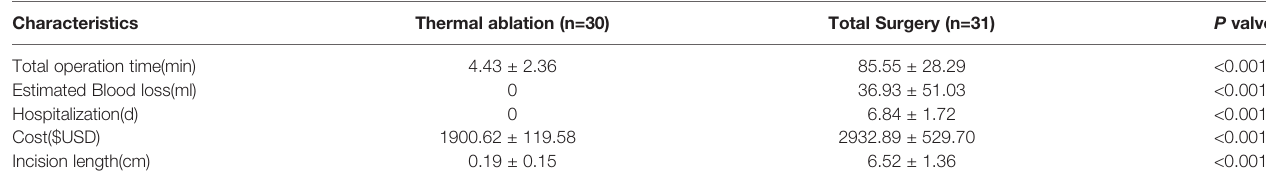
TABLE 4 | Treatment variables of the thermal ablation and the surgery groups.